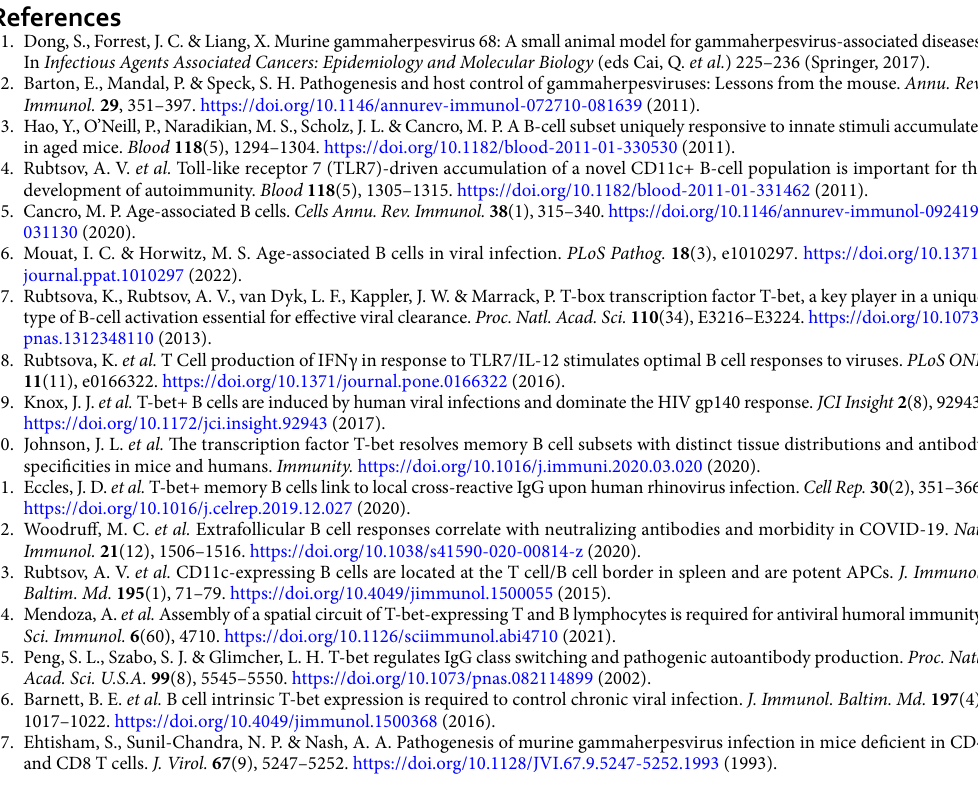
the figure legends. Statistical analyses included: two-way ANOVA with Geisser-Greenhouse’s correction, Mann– Whitney test, and one-way ANOVA. P-values indicated by asterisks as follows: ****p < 0.0001, ***p < 0.001, **p < 0.01, *p <